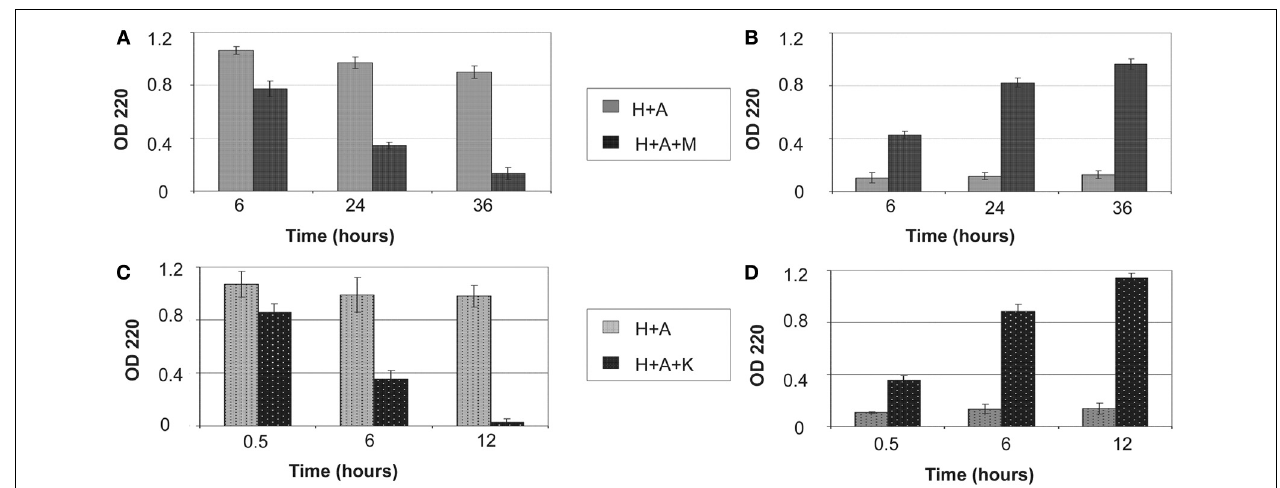
FIGURE 1 | Removal of bound amelogenin on HAP crystals by MMP-20 and KLK4 hydrolysis. (A) Protein amounts remained on crystals and (B) released into surrounding supernatant at different time points during MMP20